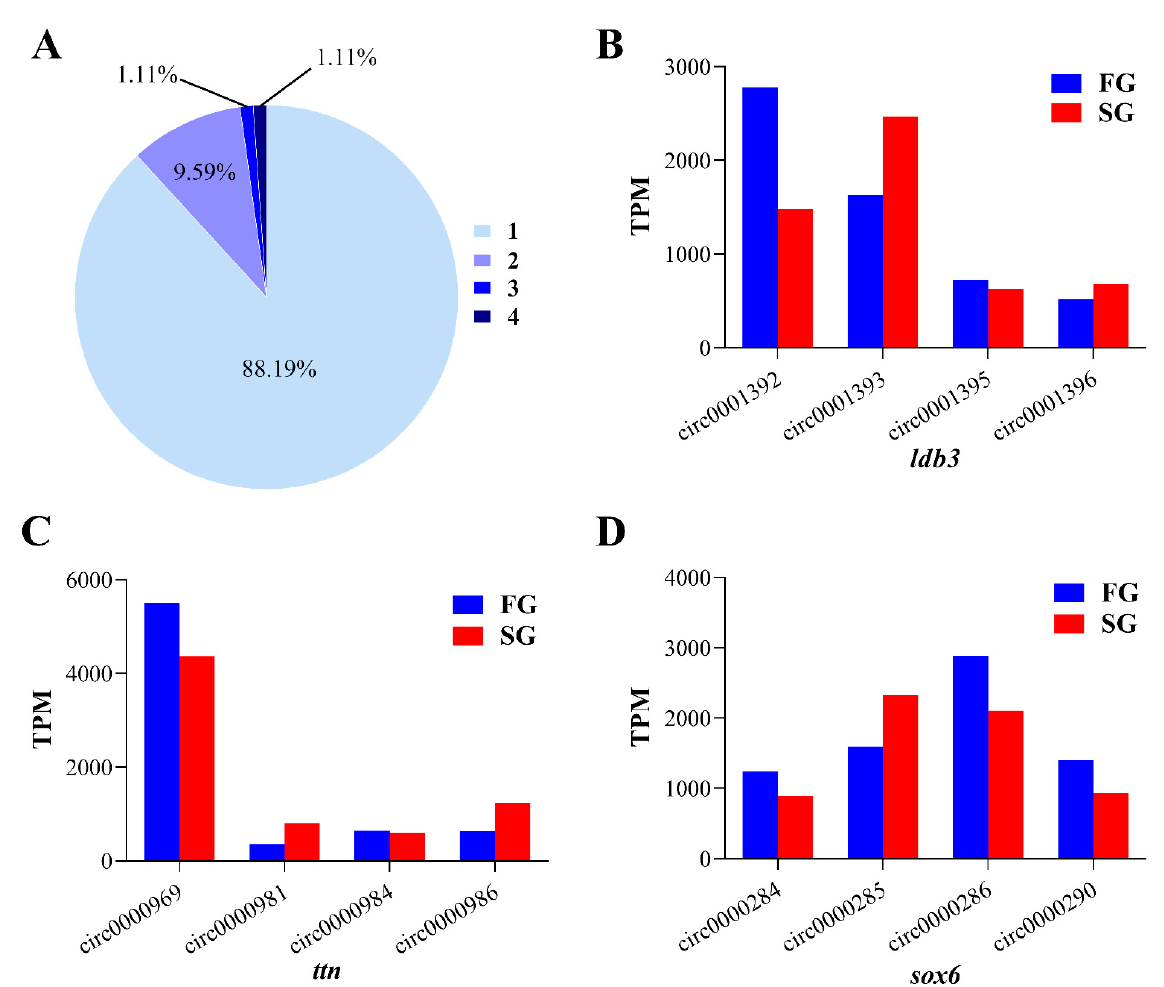
Figure 4. Characteristics of circRNAs. ( A ) Numbers of circRNAs produced by the same gene, 1–4 represents the number of circRNAs generated in the same gene. ( B – D ) Examples of genes which generated four alternative circRNAs. The x -axis shows the types of circRNA isoforms produced by the same gene and y -axis represents the expression level of circRNA isoforms.